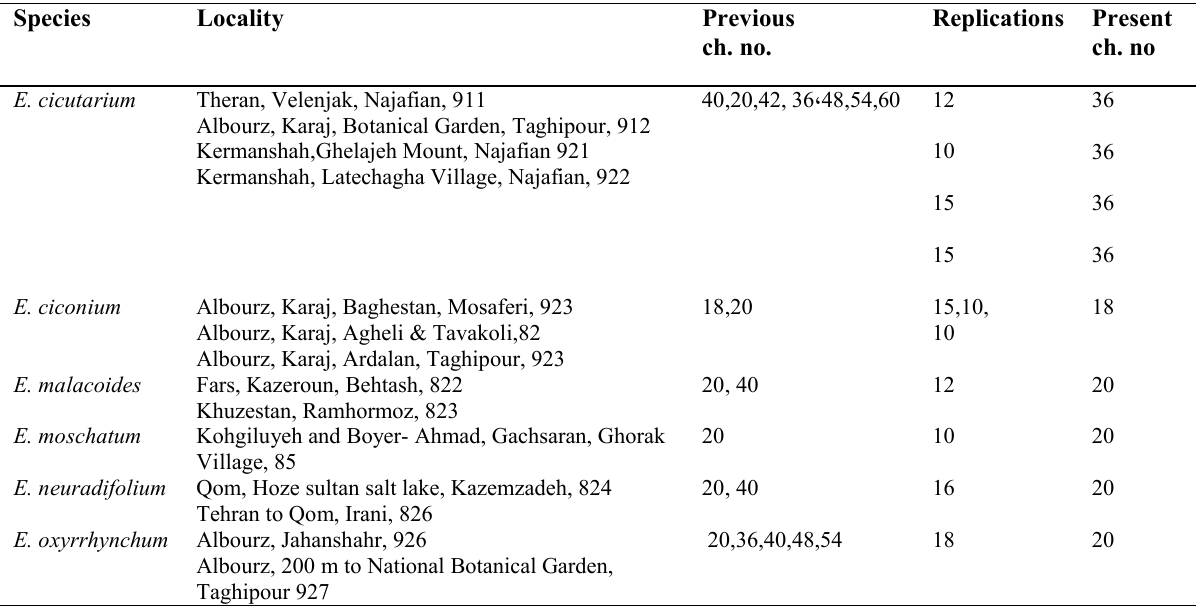
Table 1. Chromosome numbers of six studied Erodium species from Iran.